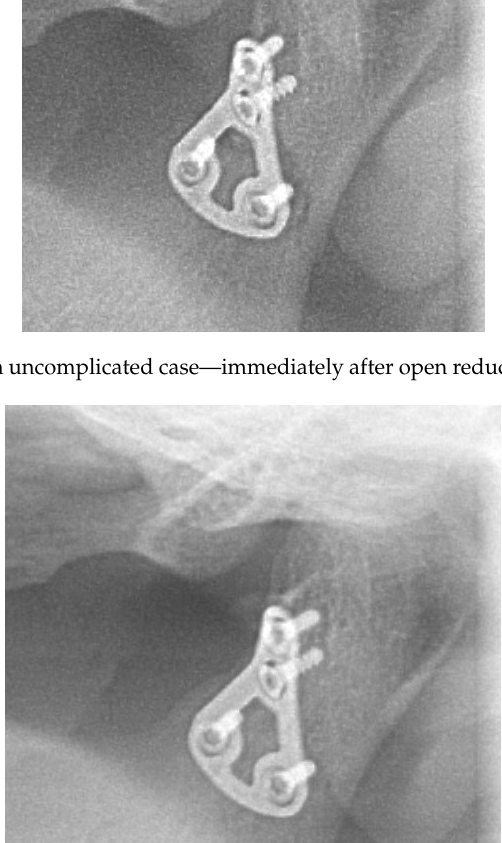
Figure 13. Patient B—A case complicated by screw loosening—immediately after open reduction and internal fixation.